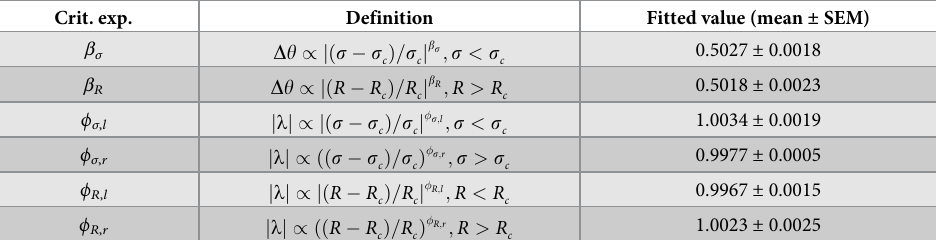
Table 1. Critical exponents as a function of the two noise sources. Critical exponents are obtained by fitting a mono- mial to the threshold differences or eigenvalues near the critical noise values (l denotes the left, and r the right side) as a function of each noise source (see S4 Fig). Crit.